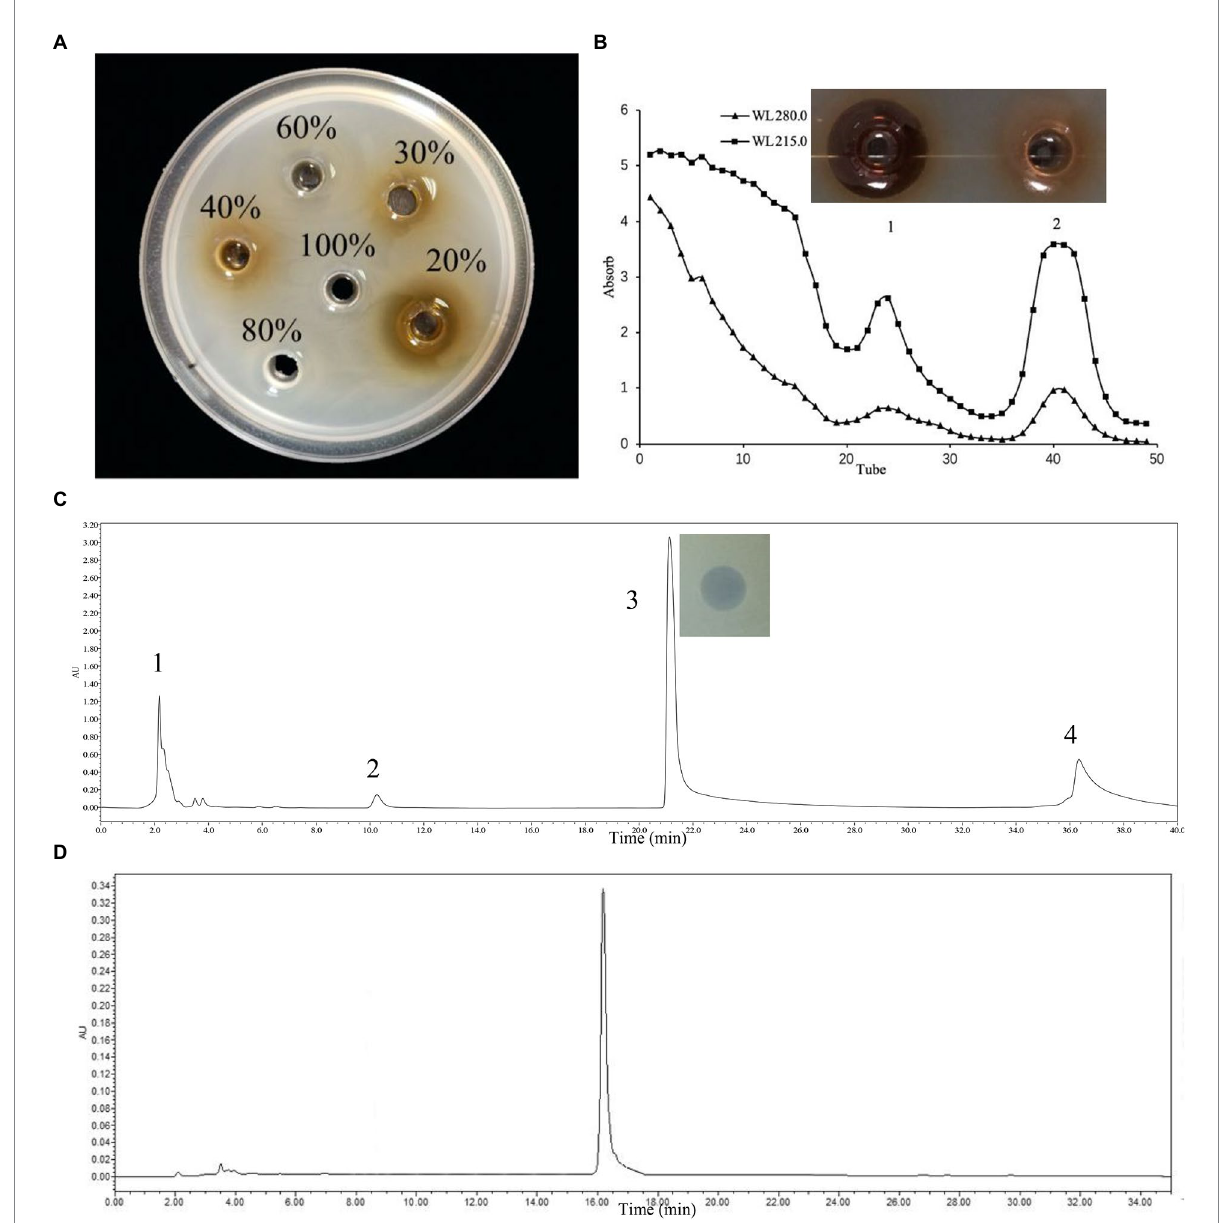
FIGURE 1 Three-step purification process of bacteriocin ZFM216 by chromatography column and antibacterial activity of absorbance peaks against S. aureus D48. (A) Macroporous resin. (B) Gel filtration. (C) Preparative PP-HPLC, peak 3 was the purified bacteriocin ZFM216. (D) Verify the purity of bacteriocin ZFM216 by analysis